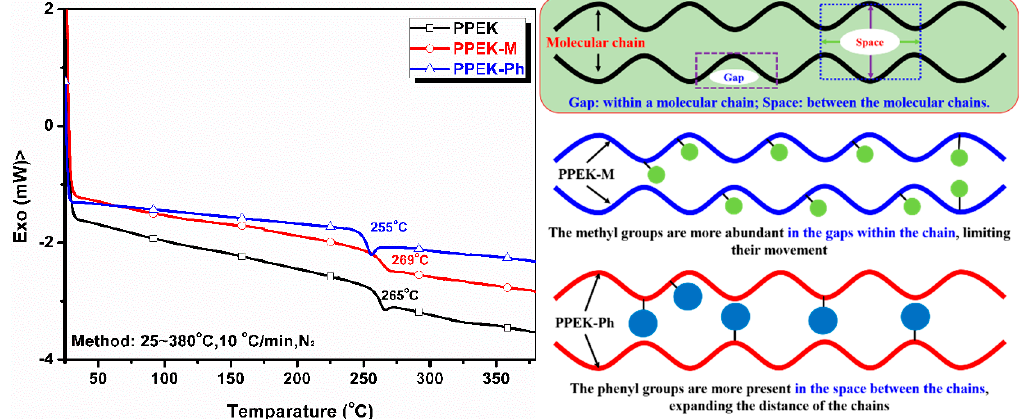
Figure 2. ( left ) Differential scanning calorimetry (DSC) curves of PPEKs resins; and ( right ) a possible explanation of this phenomenon.